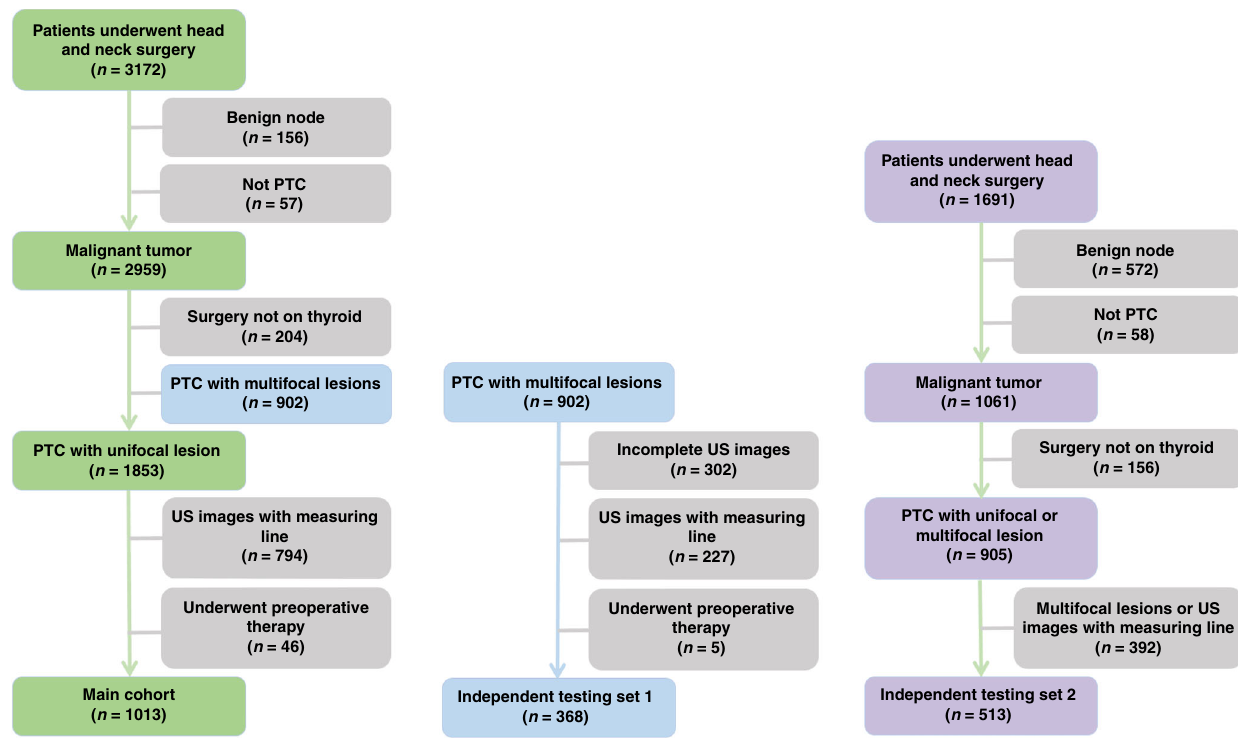
Fig. 5 Process of the patient enrollment for main cohort and two independent testing sets. The left side shows the patient enrollment process of the main cohort, the middle is the one of the independent testing set1, and the right side is the one of the independent testing set2.